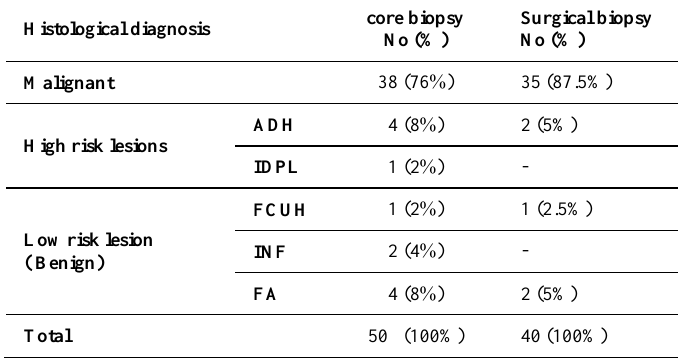
Table 5: Agreement between initial CNB diagnosis and final pathological diagnosis Histological diagnosis